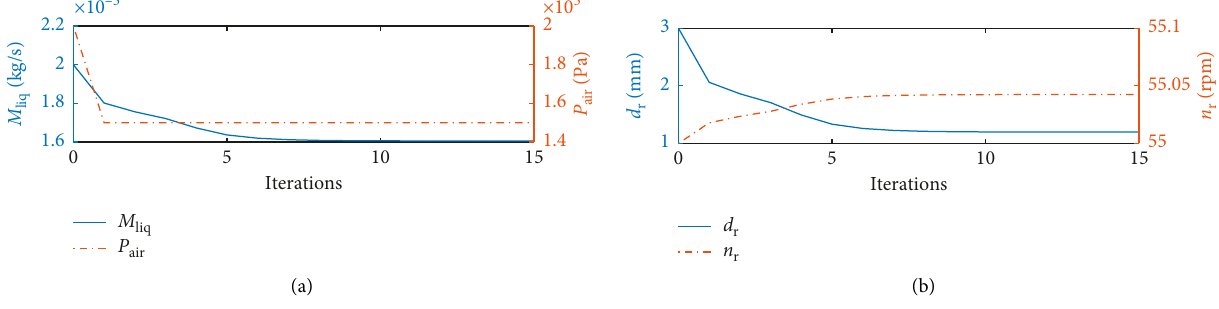
Figure 15: The simulation results of process inputs for quality